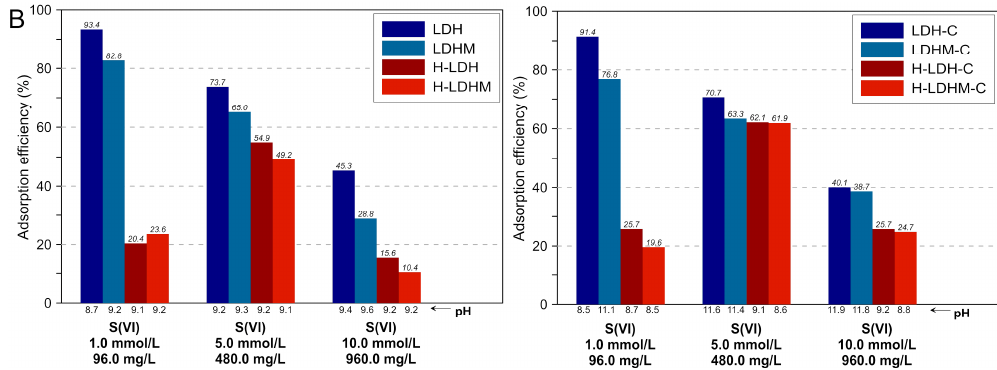
Figure 5. Adsorption efficiency of the materials in a single-element system: ( A ) Cr(VI) and ( B ) S(VI).